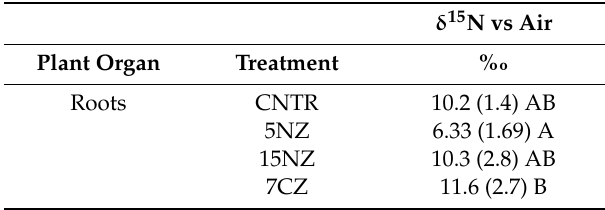
Table 5. Average 15 N natural abundance in sorghum organs at the harvest. SD within brackets. Significant ( p < 0.05) or non-significant ( p > 0.05) di ff erences between treatments for each organ are indicated by capital